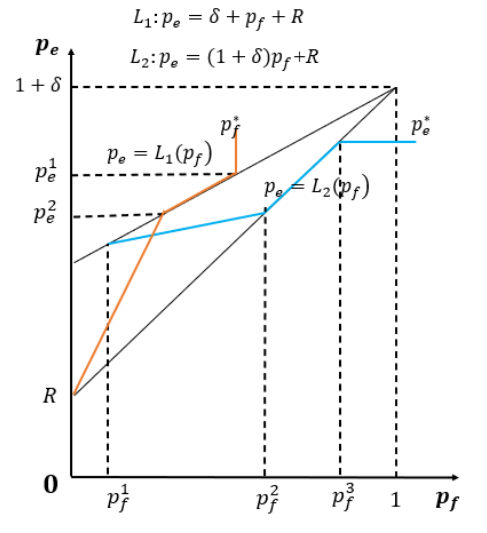
Figure A1. Best response